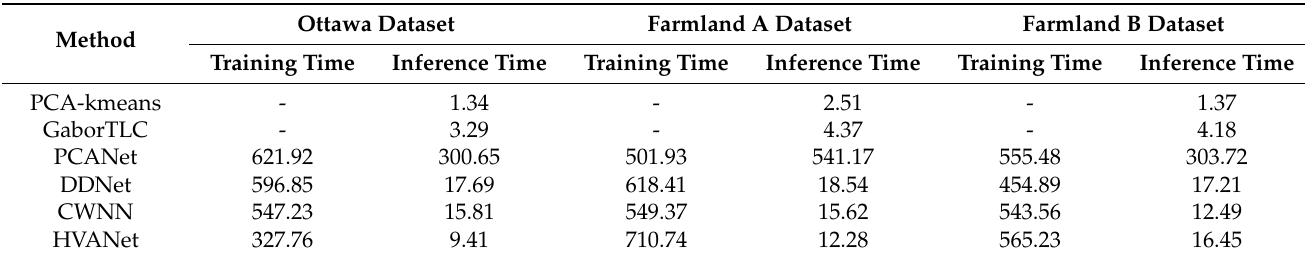
Table 12. Computational costs of different SAR image CD methods (in